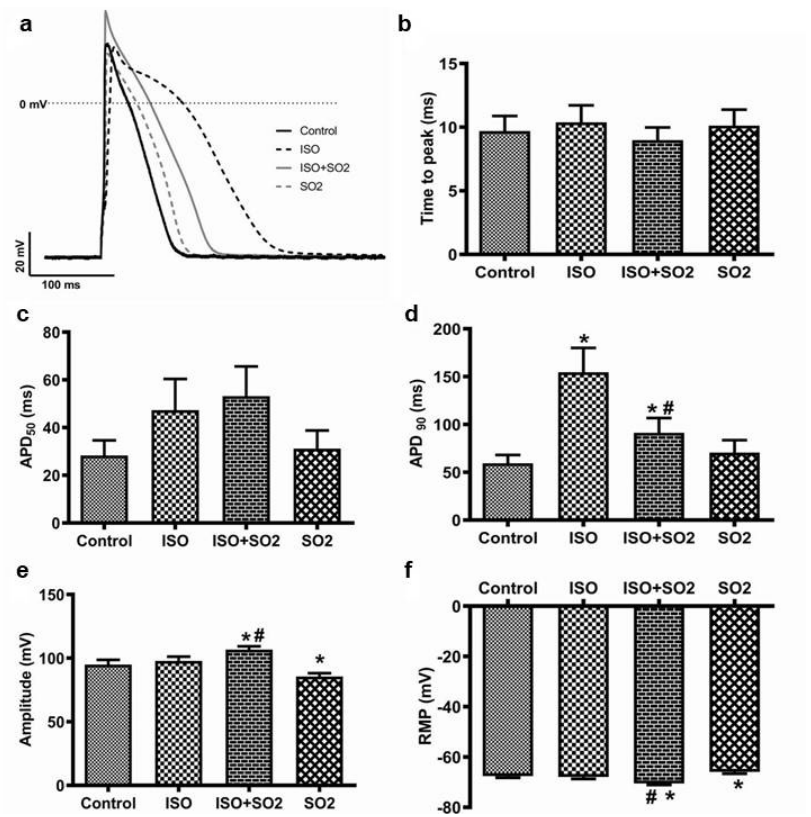
Figure 2. Action potential properties of cardiomyocytes. Representative action